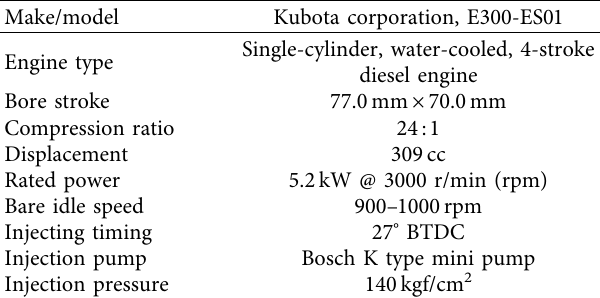
Figure 3: Materials used in the laboratory include (1) engine with eddy current type dynamometer, (2) control interface, (3) loading unit, and (4) data acquisition and management computer. Table 5: Specification of the test